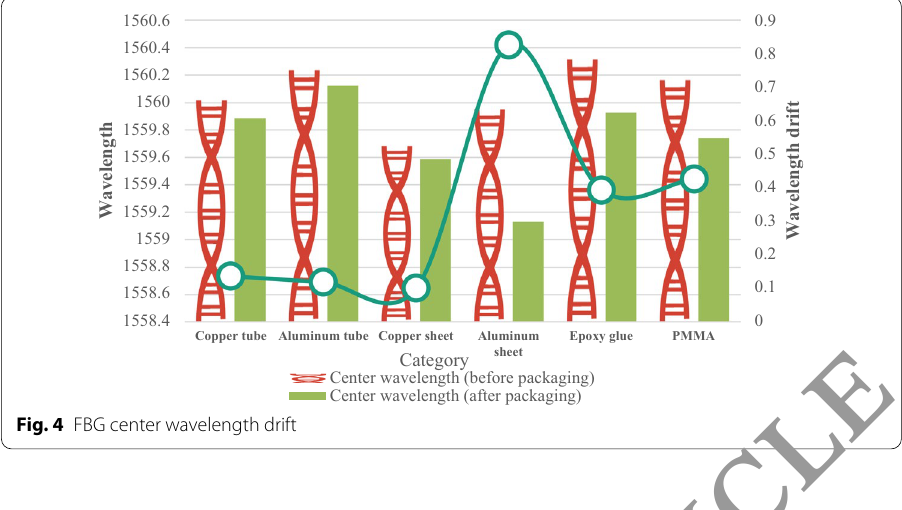
Fig. 4 FBG center wavelength drift